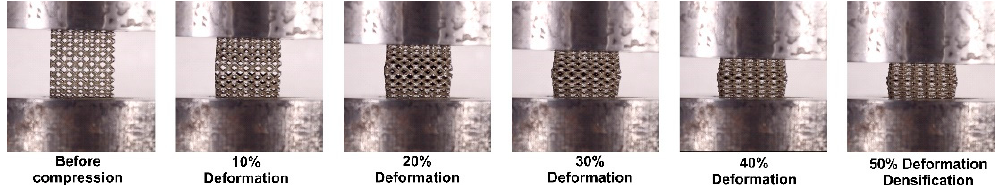
Figure 14. The main stages of the deformation process of a lattice specimen with a gradually decreasing topology.